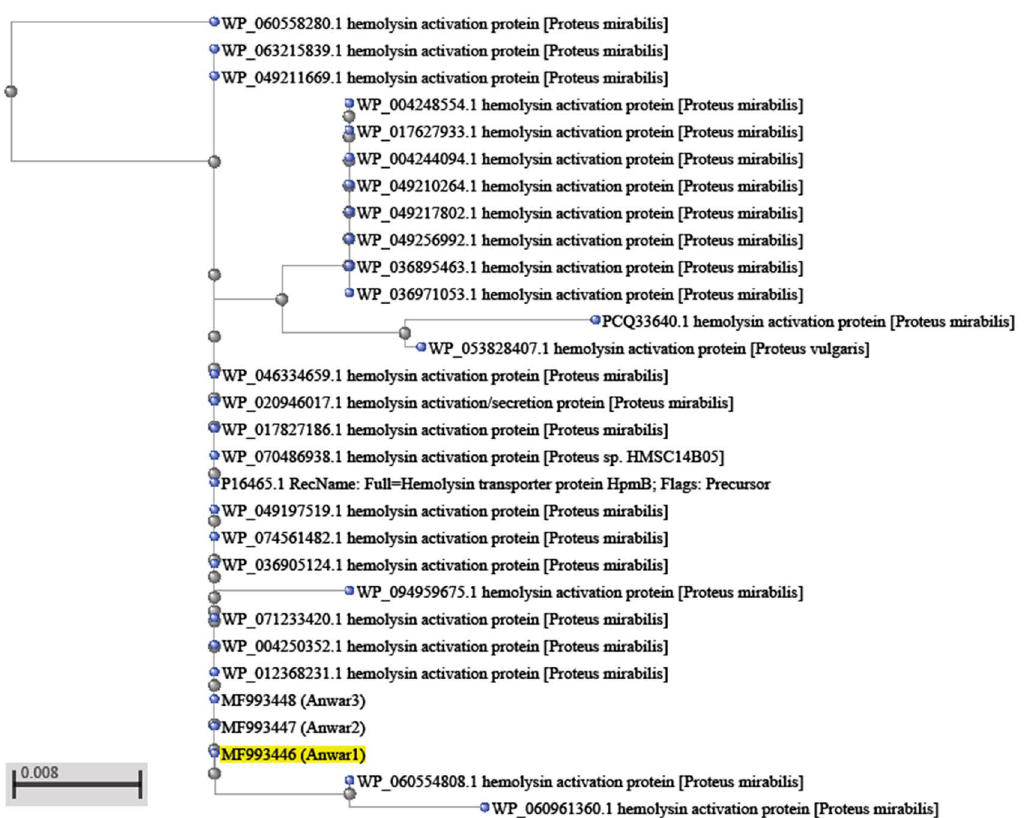
Fig. 2. Phylogenetic tree of Proteus species based on hpm B gene sequence